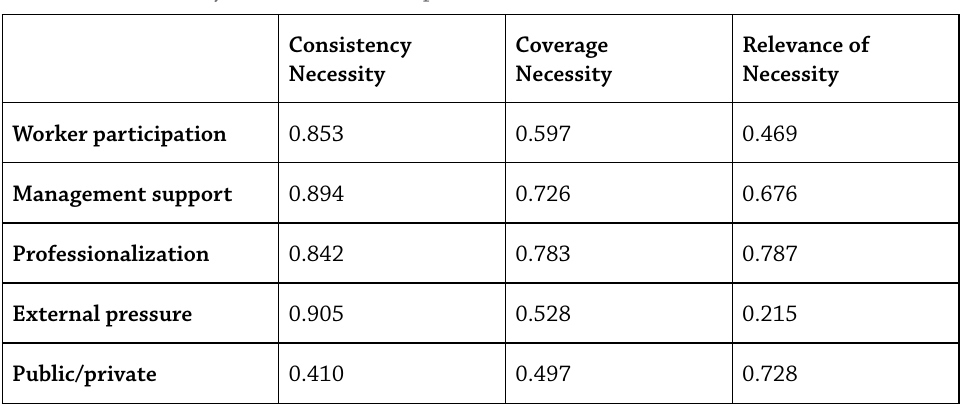
Table 7: Necessary conditions for compliance